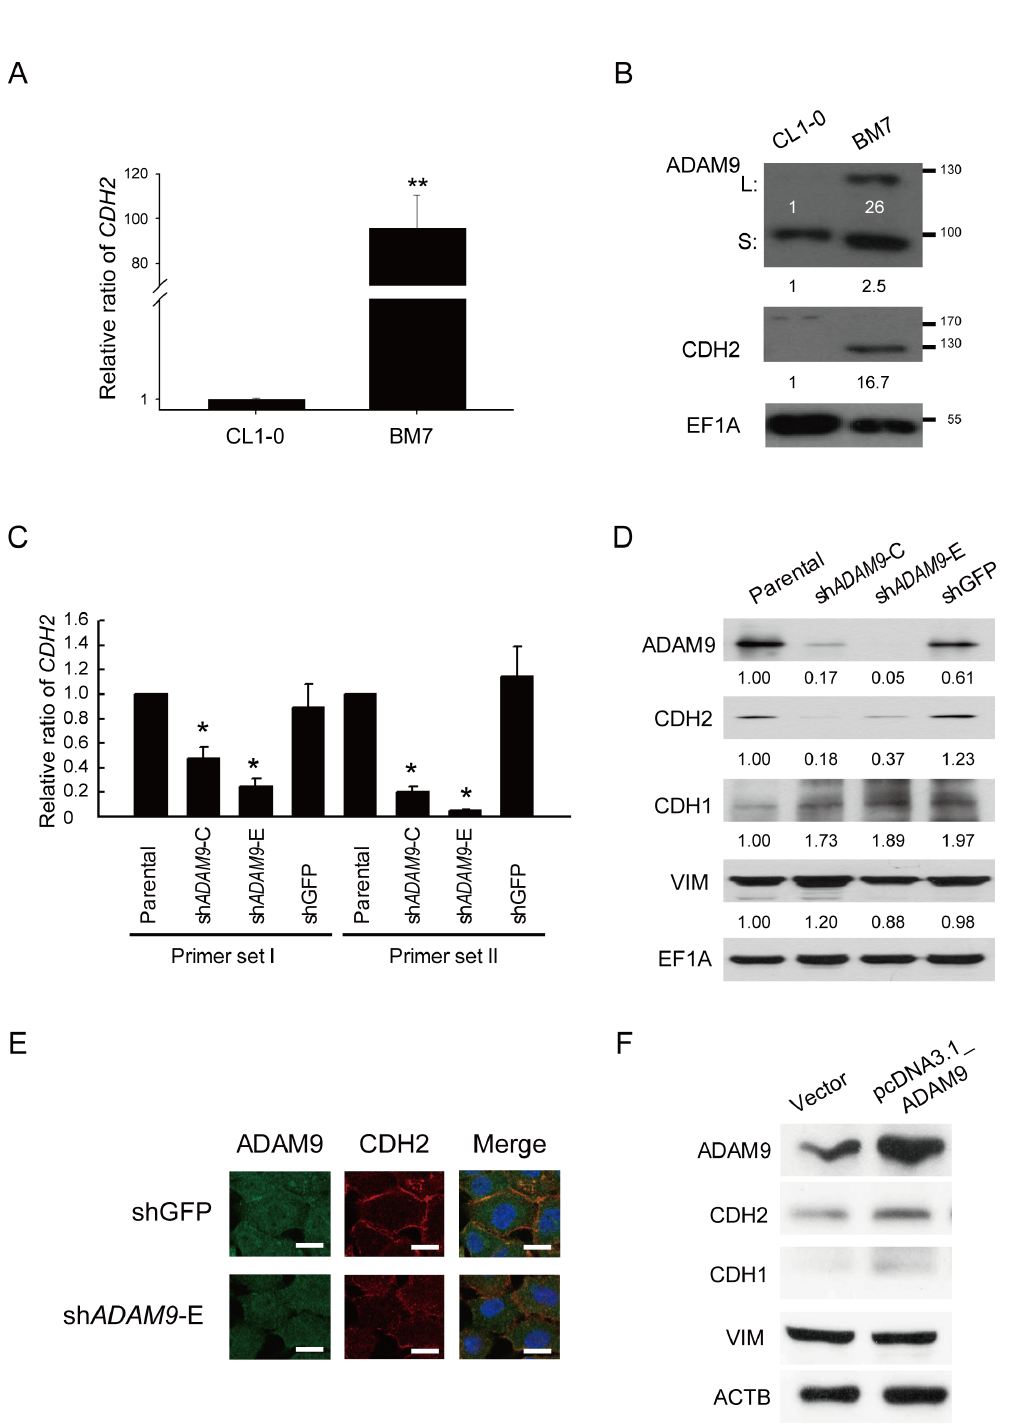
PLOS ONE | www.plosone.org 4 April 2014 | Volume 9 | Issue 4 |